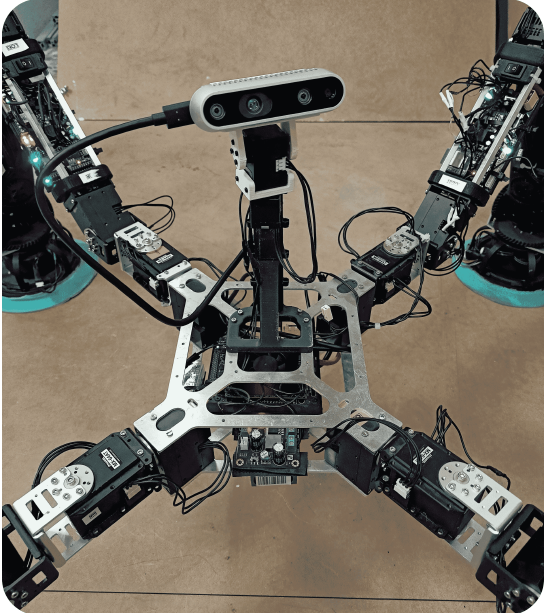
Figure 3. Constructed body for a 4-legged robotic